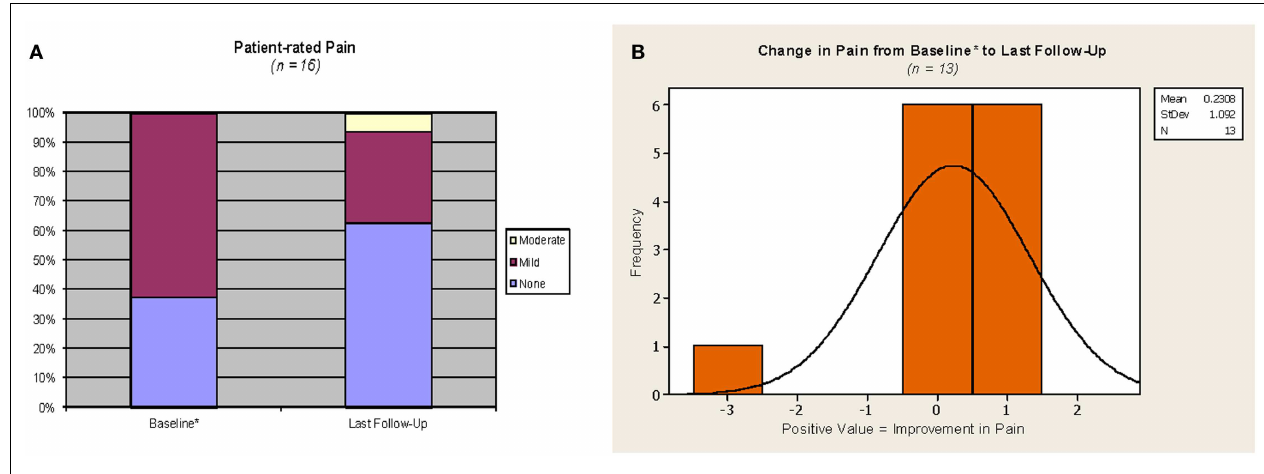
infrequent discomfort or mild frequent pain = mild; moderate and constant pain = moderate; severe pain or pain requiring hospitalization = severe. (A) Yellow = moderate, maroon = mild, purple = none. (B) Orange with solid line = patient-rated change in